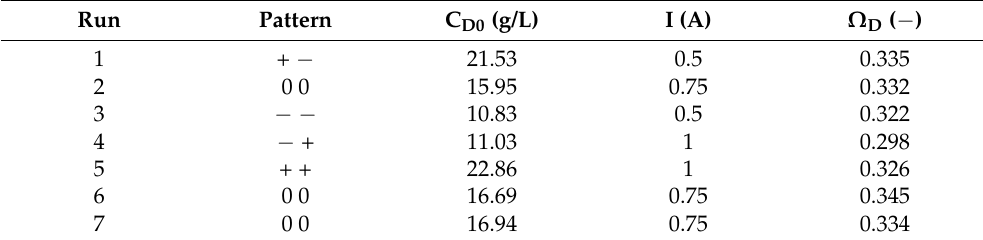
Table 2. Coded and natural levels of initial concentration of the diluting solution (C D0 ) and electrical current intensity (I) together with Faraday efficiencies ( Ω D ) determined for the diluting tank for the deacidification experiments. Run Pattern C D0 (g/L) I (A) Ω D ( − ) 1 + − 21.53 0.5 0.335 2 0 0 15.95 0.75 0.332 3 − − 10.83 0.5 0.322 4 − + 11.03 22.86 0.326 0 0 16.69 0.75 16.94 0.75